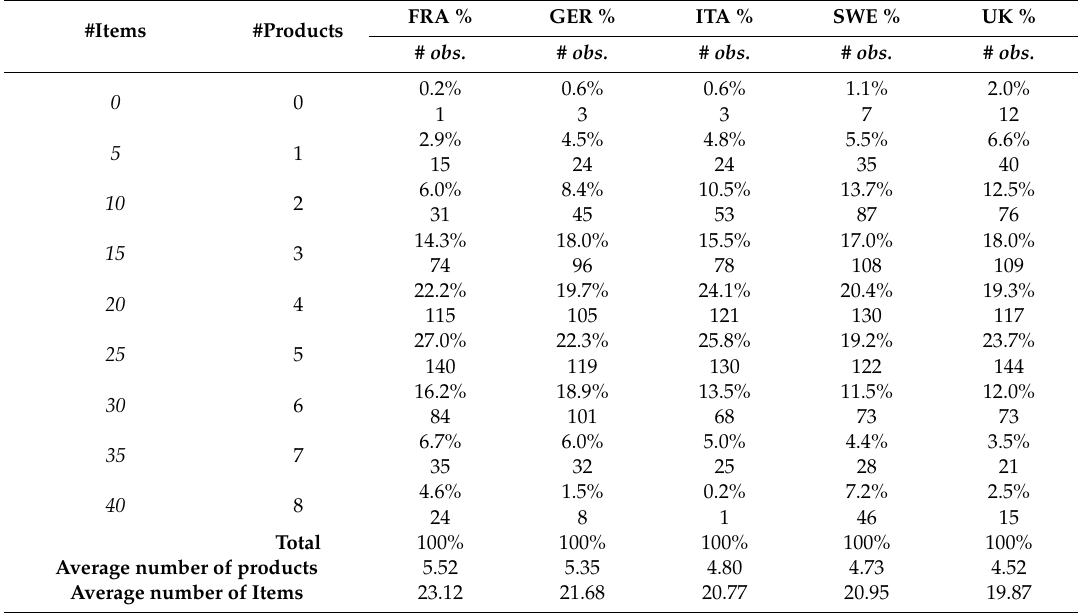
Table A1. Distribution of the number of products “do NOT use”, necessary to assess the “Unbiased” financial literacy